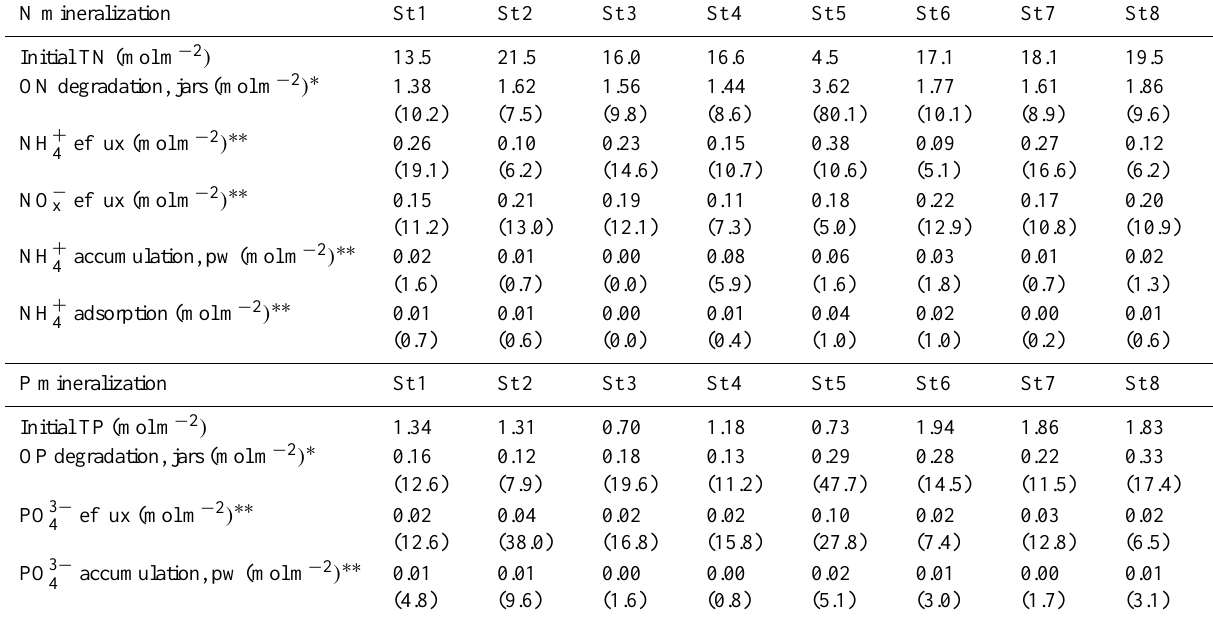
Table 5. N and P budgets for the experiment. Initial TN and TP are the depth-integrated values based on initial measurements. ON and OP degradation were calculated based on area-specific rates obtained from jar experiments. Total NH + by time integration of effluxes over the entire experimental period. NH + difference between initial and final pw profiles. NH + NH + -adsorption coefficient for each station. Values in parentheses marked with ∗ or ∗∗ represent percentage relative to initial TN and TP or 4 total N and P mineralization,